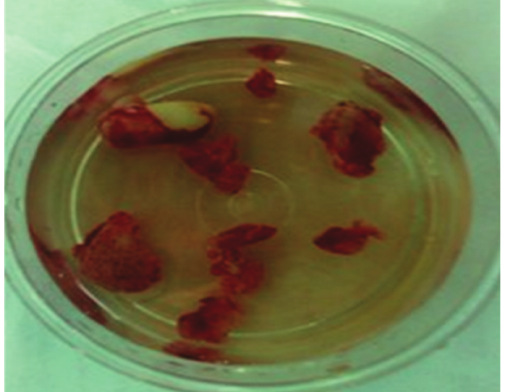
Figure 11: Biopsy specimen.